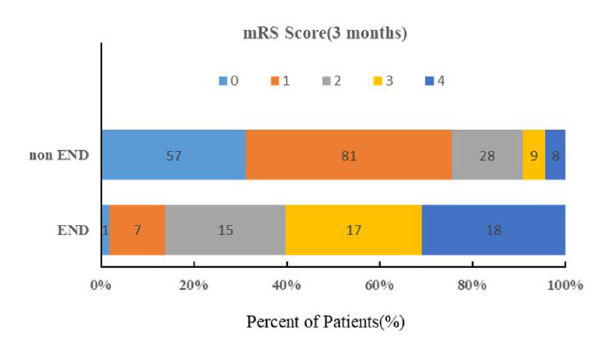
FIGURE2 Comparison of the mRS scores at 3 months between the END group and No-END group.